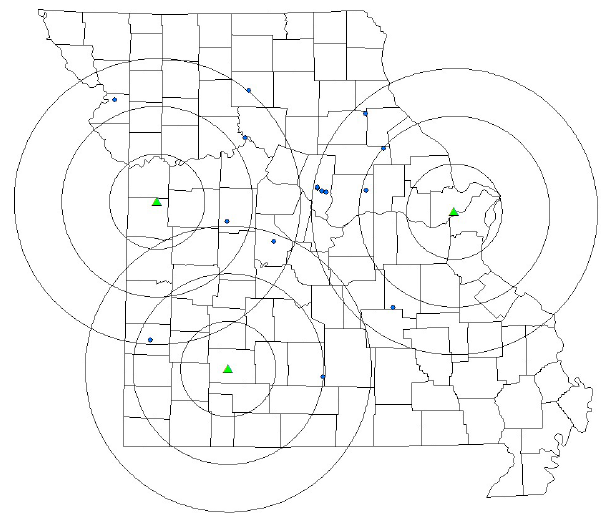
Figure 1. Study location (Missouri) with St. Louis (KLSX), Kansas City (KEAX), and Springfield (KSGF), MO, radars (triangles) overlaid with 50, 100, and 150km range rings in addition to the 15 terrestrial-based precipitation gauges utilized as ground-truthed